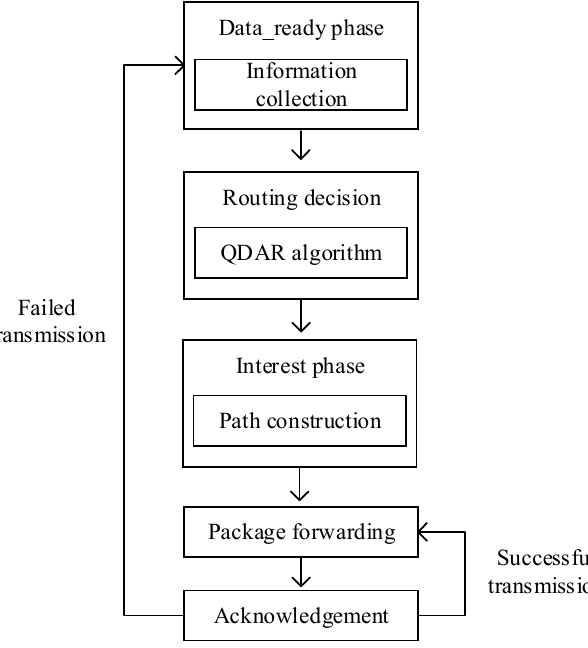
Figure 1. Q-learning based delay-aware routing mechanism.